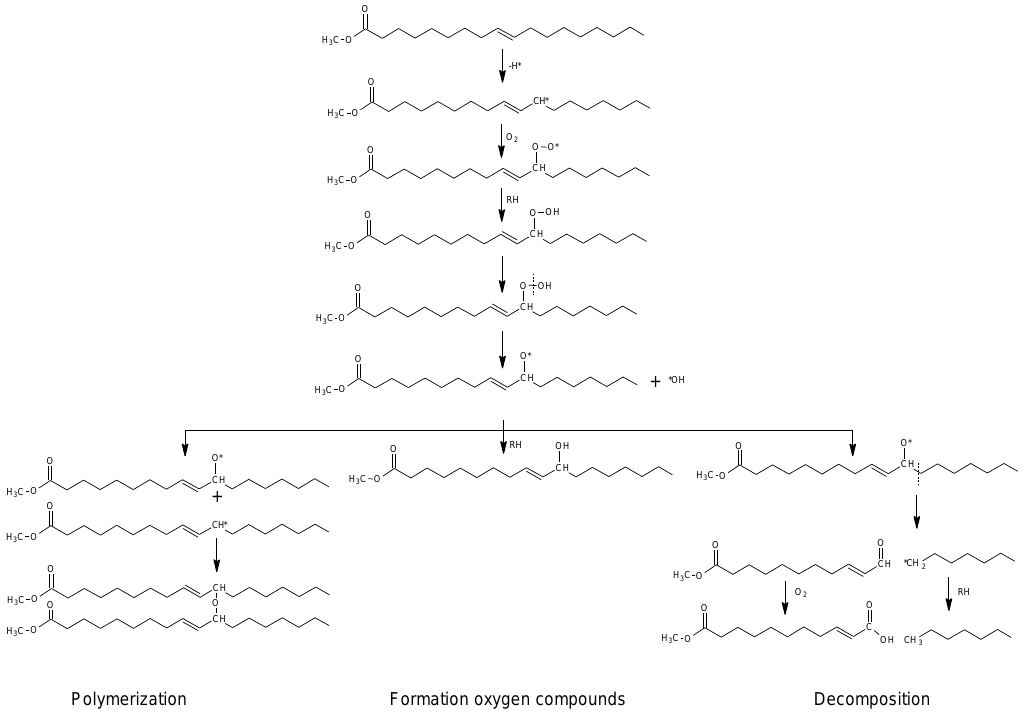
Figure 7. Reaction pathways of catalytic oxidation of oleic acid methyl ester.